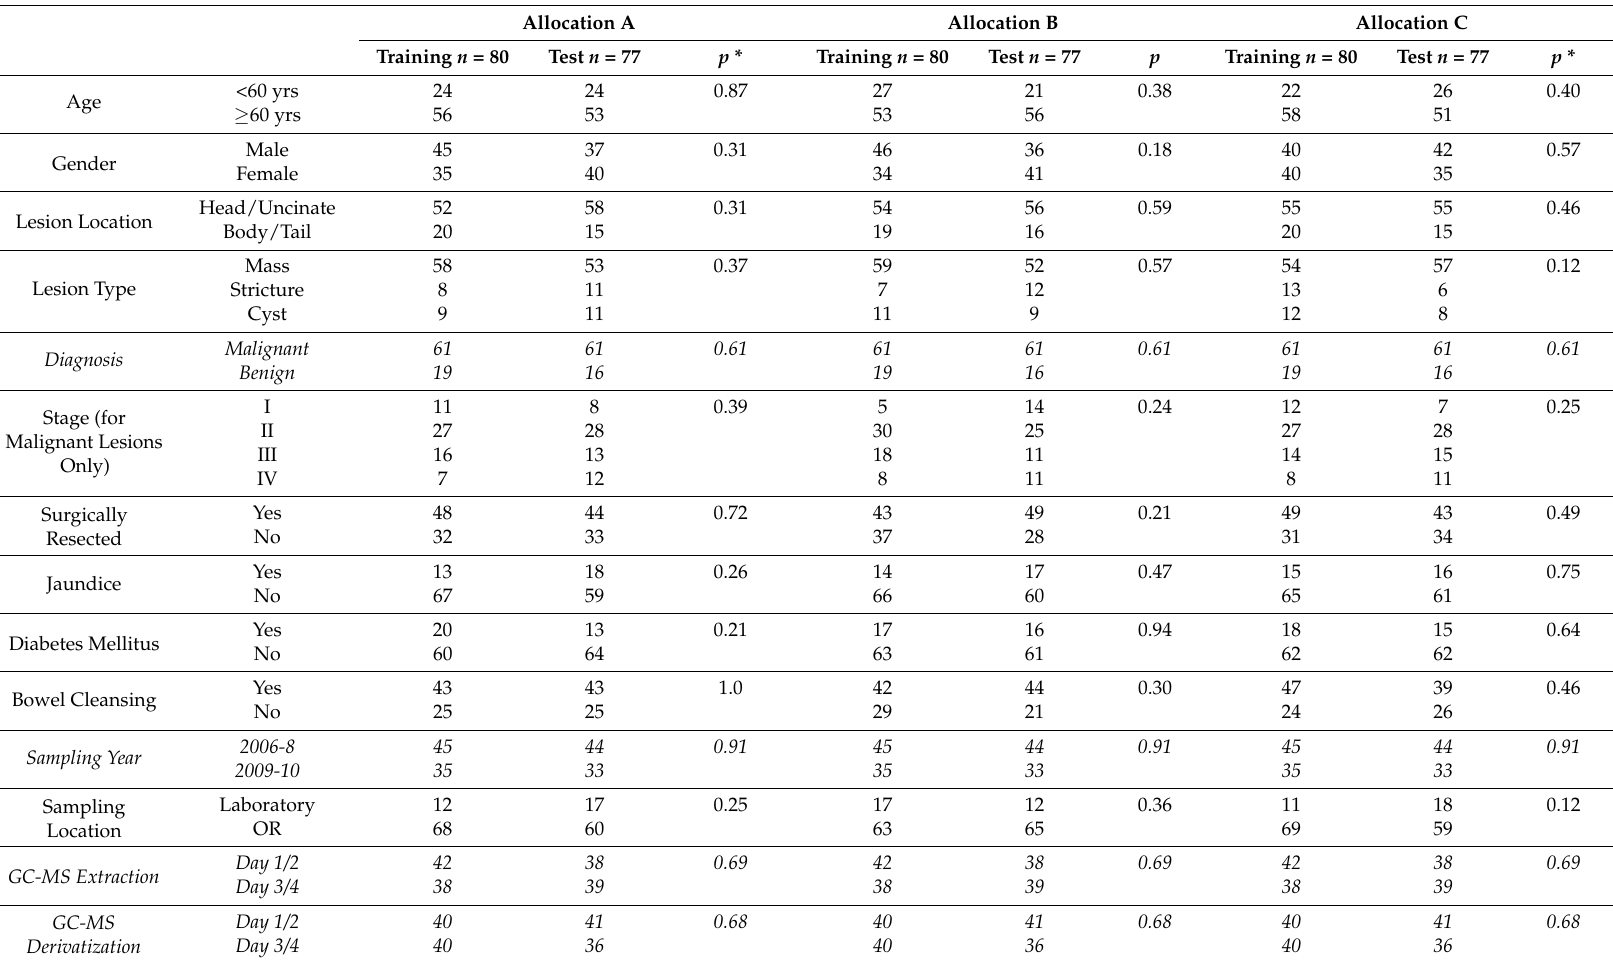
Table 1. Clinical and technical variables for each allocation of training and test